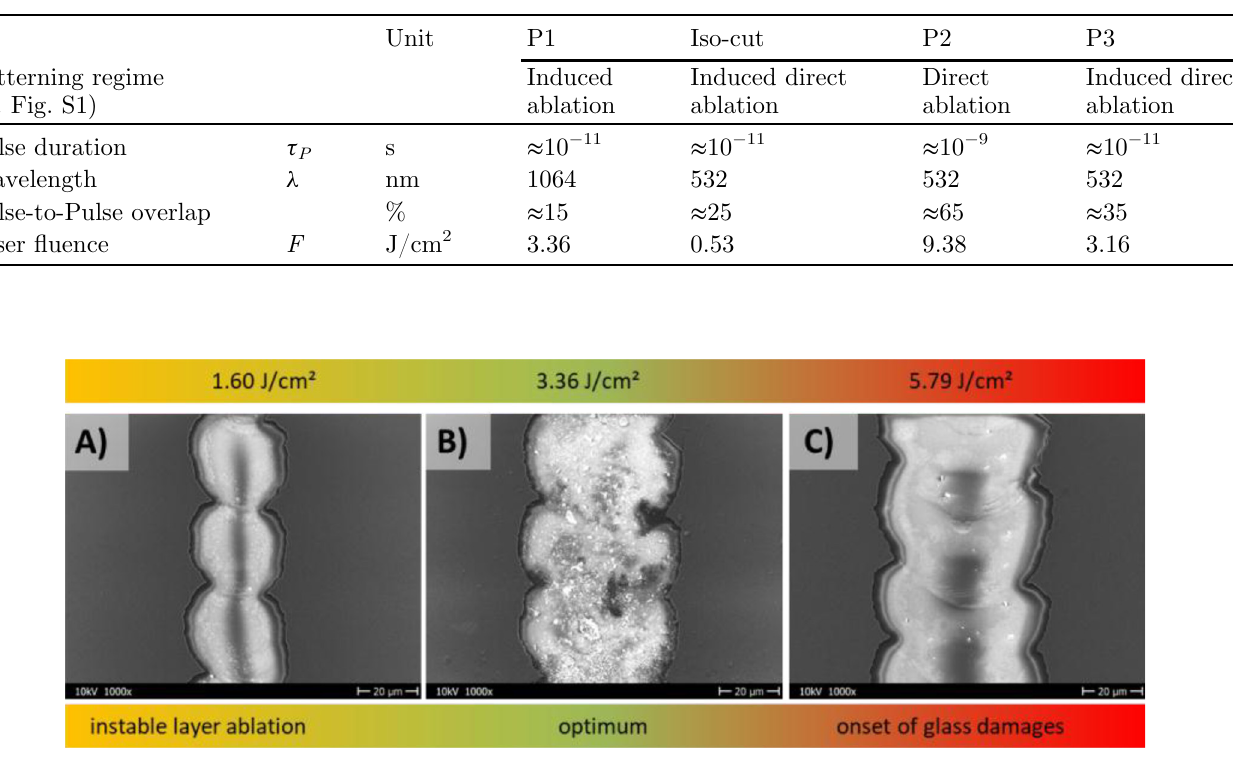
Table 1. Experimentally determined optimal parameters used for laser patterning.